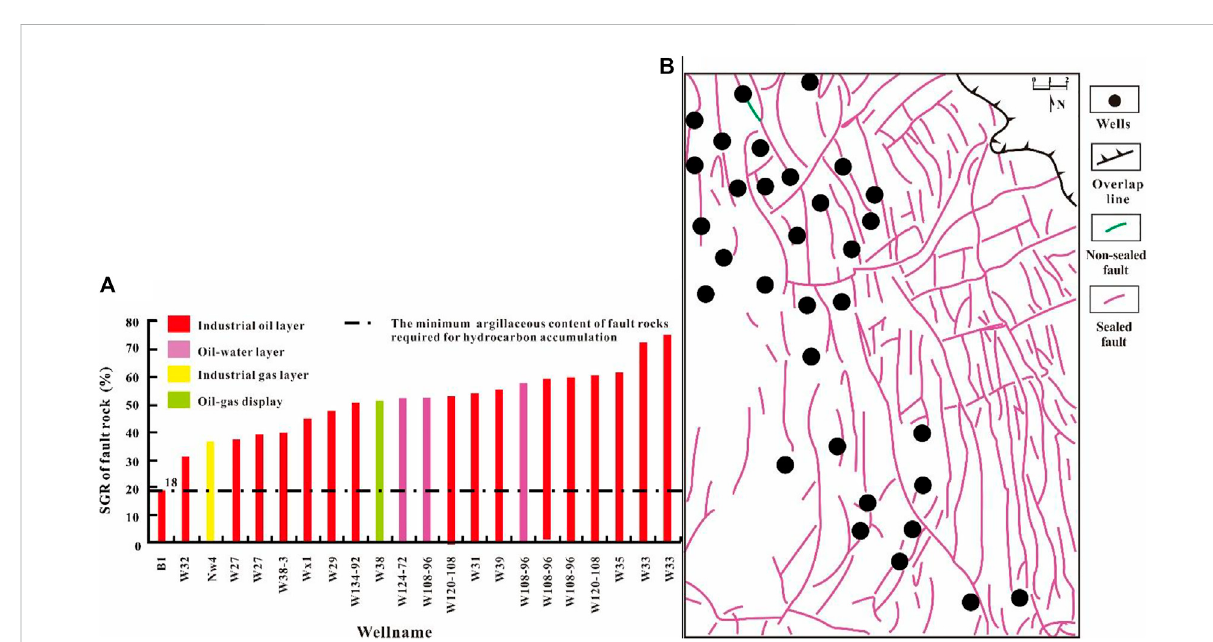
Evaluationmapoflateralfaultsealingofthe fi rstmemberoftheNantunFormation(K 1 n 1 )intheWunanslopearea; (A) Theminimumargillaceous content of fault rocks required to close the fault; (B) The distribution of lateral sealing